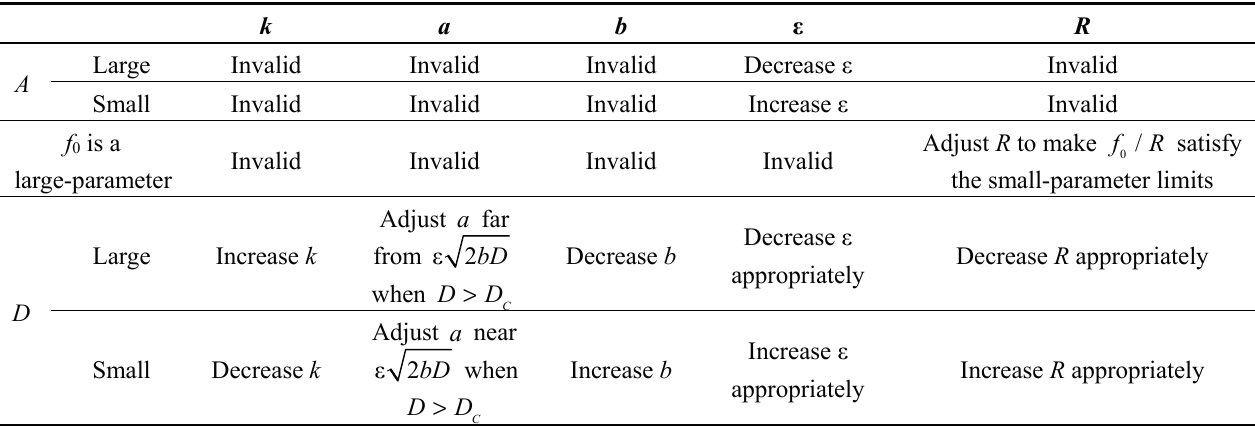
Table 1. GPASR rules in a Duffing oscillator under unmatched signal amplitude A , frequency f 0 (being large-parameter) and/or noise-intensity D